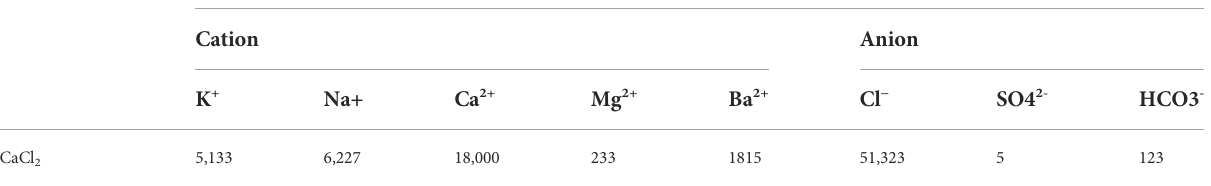
TABLE 3 Initial ion content of formation